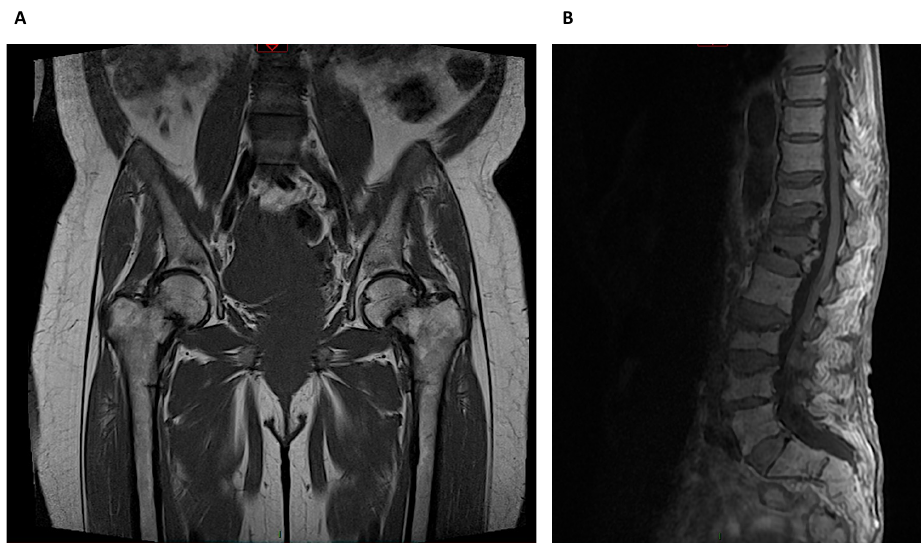
Figure 6. Magnetic Resonance Imaging: ( A ) Bilateral metaphyseal femoral fractures distal to the lesser trochanter with reactional associated bone edema in a hemodialysis patient with osteomalacia. ( B ) Osteoporotic lumbar spine compression fracture at T11, T12, L1, L3 and L4 vertebral body that is hyperintense on T2 and shows vivid contrast enhancement with paravertebral soft tissue edema.